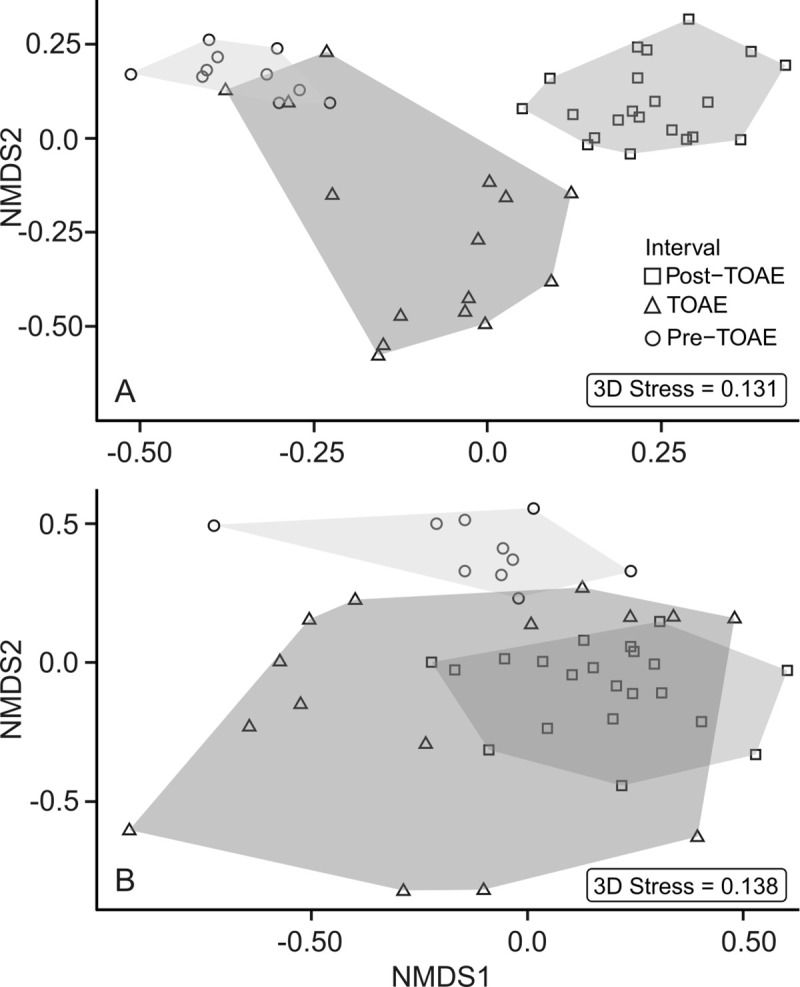
Non-metric multidimensional scaling ordination (NMDS) of faunal samples at Barranco de la Cañada.Results plotted by taxonomical (A) and ecological (B) composition. The symbols and the shading of the convex-hull polygons are coded by interval (pre-TOAE, TOAE and post-TOAE).